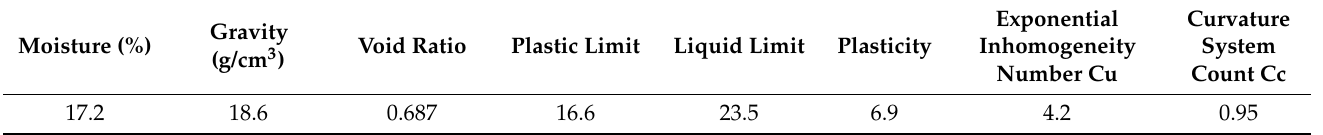
Table 1. Basic physical and mechanical properties of silt in eastern